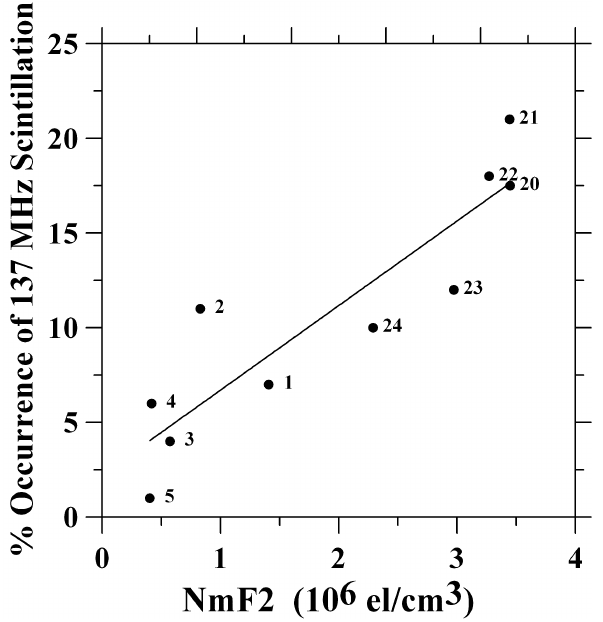
Fig. 7. Scintillation occurrence at 137MHz as a function of Nm F2 as observed on March–April 1969 at Taipei. Labels on the points are the local times of the